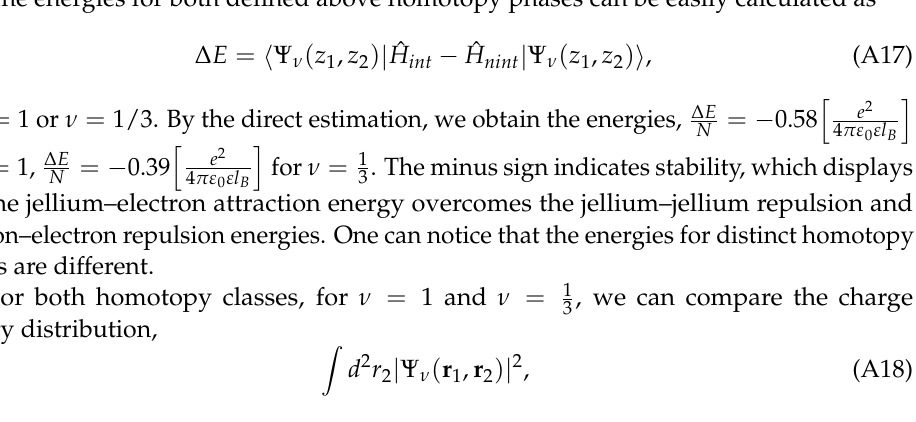
(cid:82) d 2 r 2 | Ψ ν ( r 1 , r 2 ) | 2 for ν = 1 (brown) and Figure A5. Single-particle density for the wave function, ν = 1 (blue)—pushing of charge density out of the center is visible for a homotopy class at ν = 1 3 (cid:82) (cid:82) d 2 r 2 d 2 r 1 Ψ ∗ ν ( r 1 , r 2 ) | r 1 − r 2 | Ψ ν ( r 1 , r 2 )) , is larger for panel). The averaged separation of particles, the homotopy class for ν = 1 (the averaged distance is presented by the circle diameter) (right panel). 3